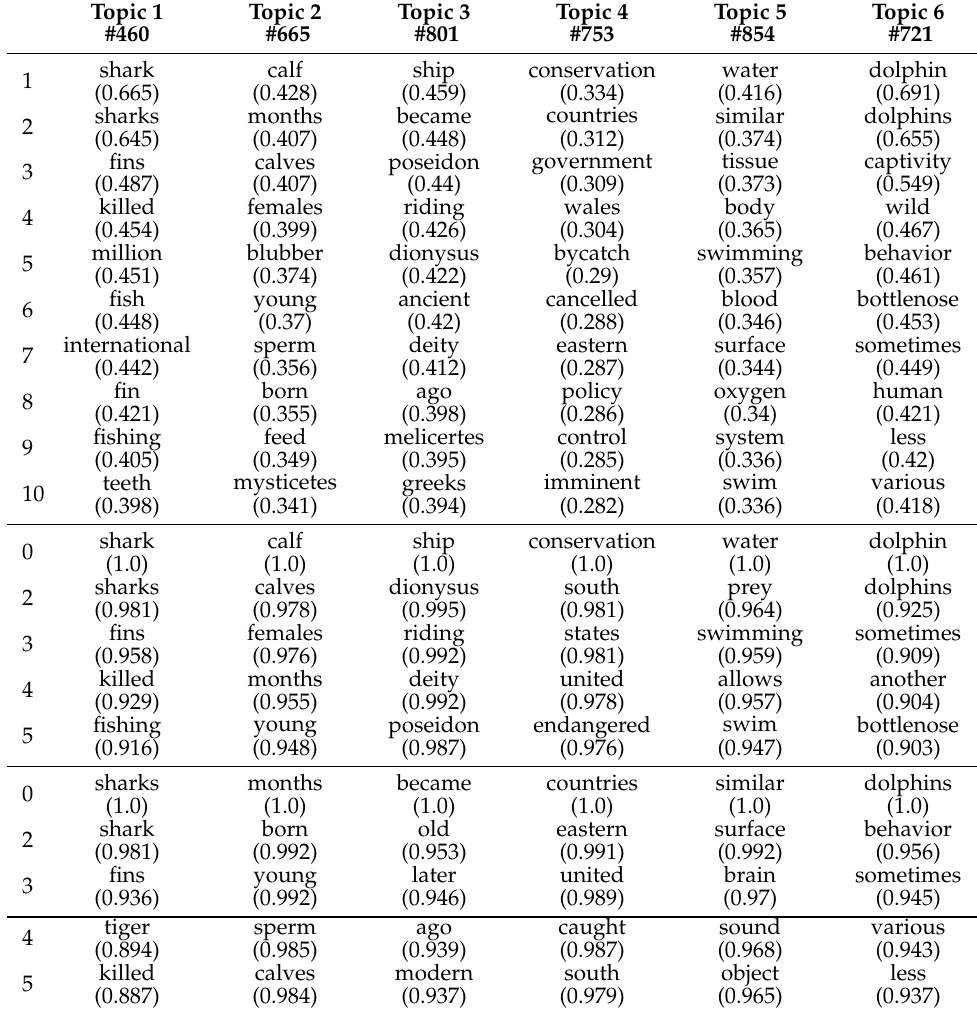
Table A2. Top half lists the top 10 representative words per dimension of the basis matrix A , bottom half lists the five most similar words based on cosine similarity for the two top words from each